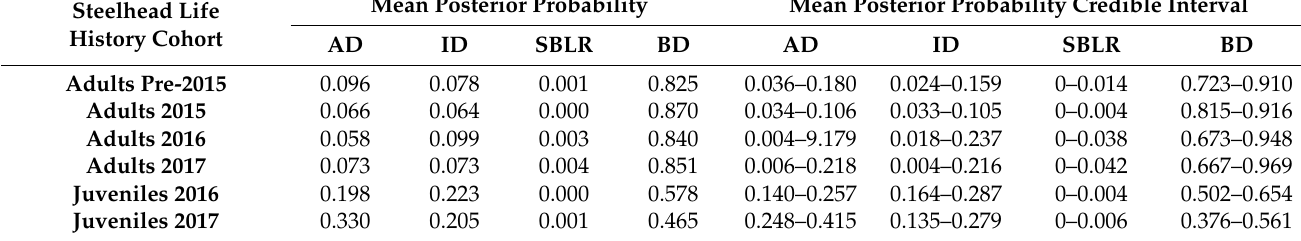
Table 3. The mean probability of assignment to each population represented in the steelhead